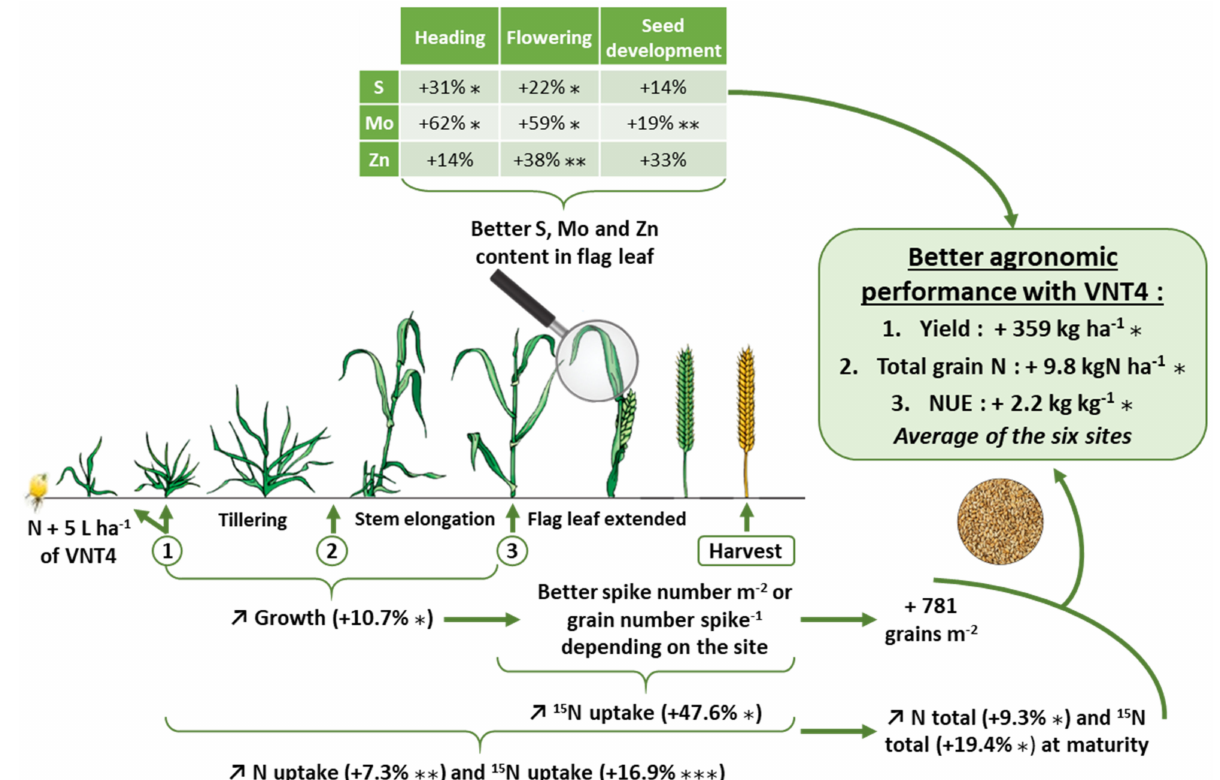
Figure 5. Schematic model illustrating the response of wheat to VNT4 supply. Application of VNT4 along N fertilizer improved plant growth during tillering and stem elongation and induced an increase in the spike number per square metre or the grain number per spike, depending on the site. This stimulation enabled production of more grain per square metre. VNT4 also enhanced the accumulation of N and 15 N (especially after the last application) during the crop cycle leading to a higher N and 15 N total in aerial parts at maturity. In addition, application of VNT4 significantly increased the S, Mo and Zn content after the third supply at the flag leaf stage. Taking into account the six sites in 2019 and 2020, the average data revealed better agronomic performance with higher yield, total grain N and NUE when VNT4 was applied to wheat plants. Stars denote significant differences between control and VNT4 (*; p < 0.05, **; p < 0.01, ***; p <